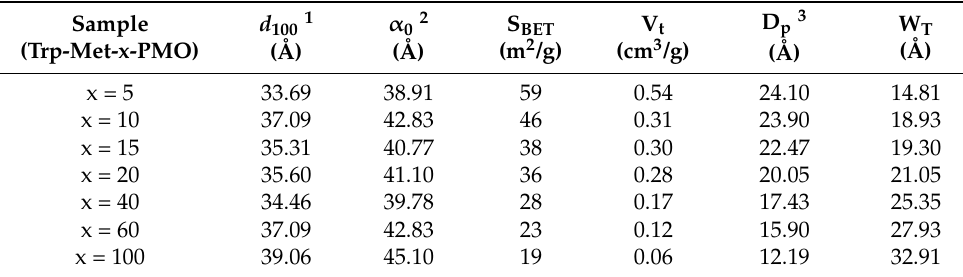
Figure 2. Wide-angle XRD patterns of Trp-Met-x-PMO (x = 5, 10, 15, 20, 40, 60, 100). Table 1. Structural parameters of materials Trp-Met-x-PMO (x = 5, 10, 15, 20, 40, 60, 100) with the different amounts of